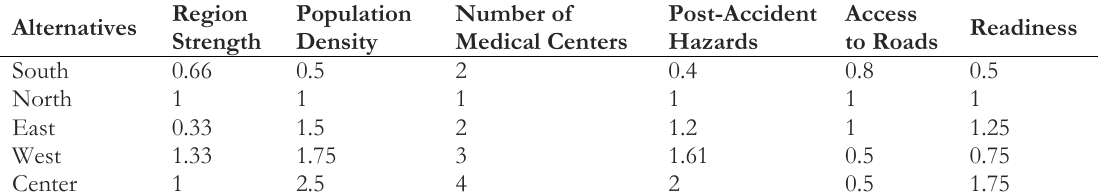
Fig. 3. Regions studied in Amol city to establish a relief center. Table 2. Initial decision-making matrix.